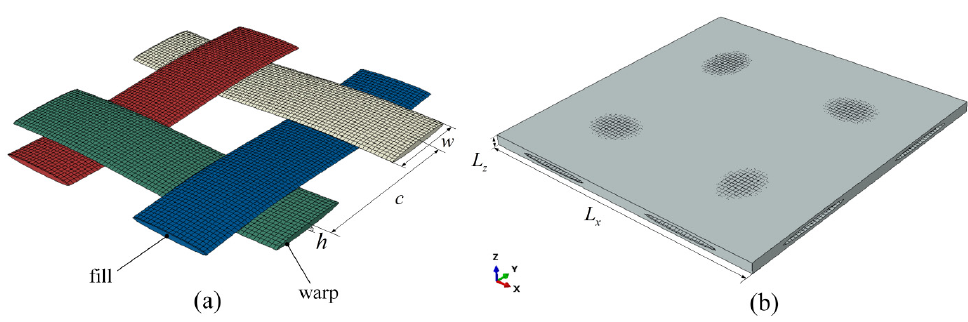
Figure 5. FE model of mesoscale RVE: ( a ) the woven yarn; ( b ) the matrix.